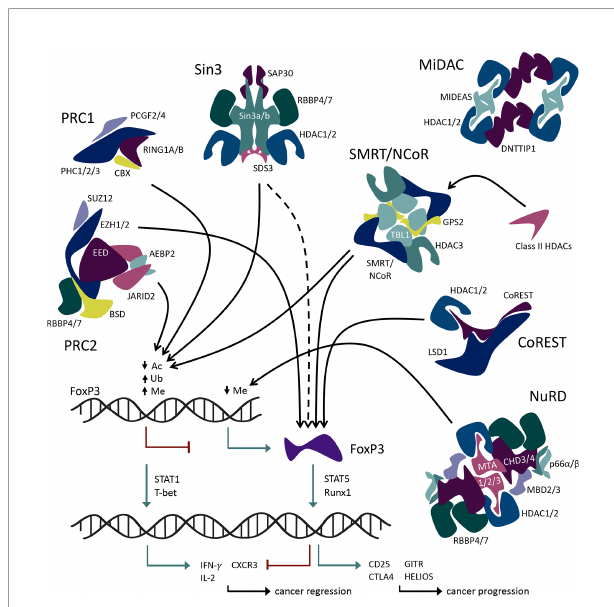
FIGURE 2 | Interactions of large multiprotein coregulatory complexes with Foxp3.